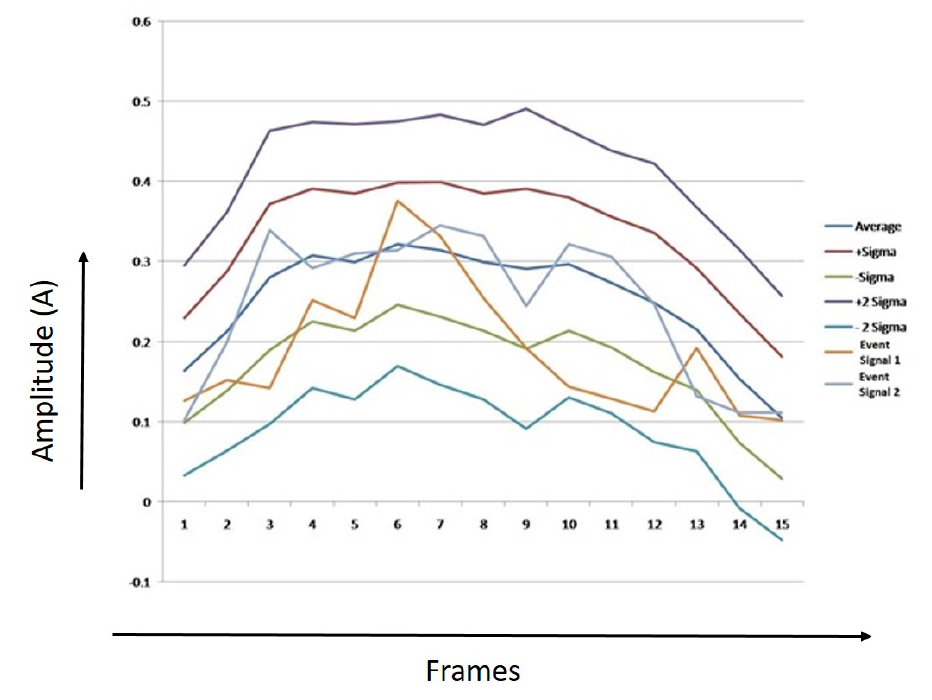
Figure 24. Threshold boundaries for